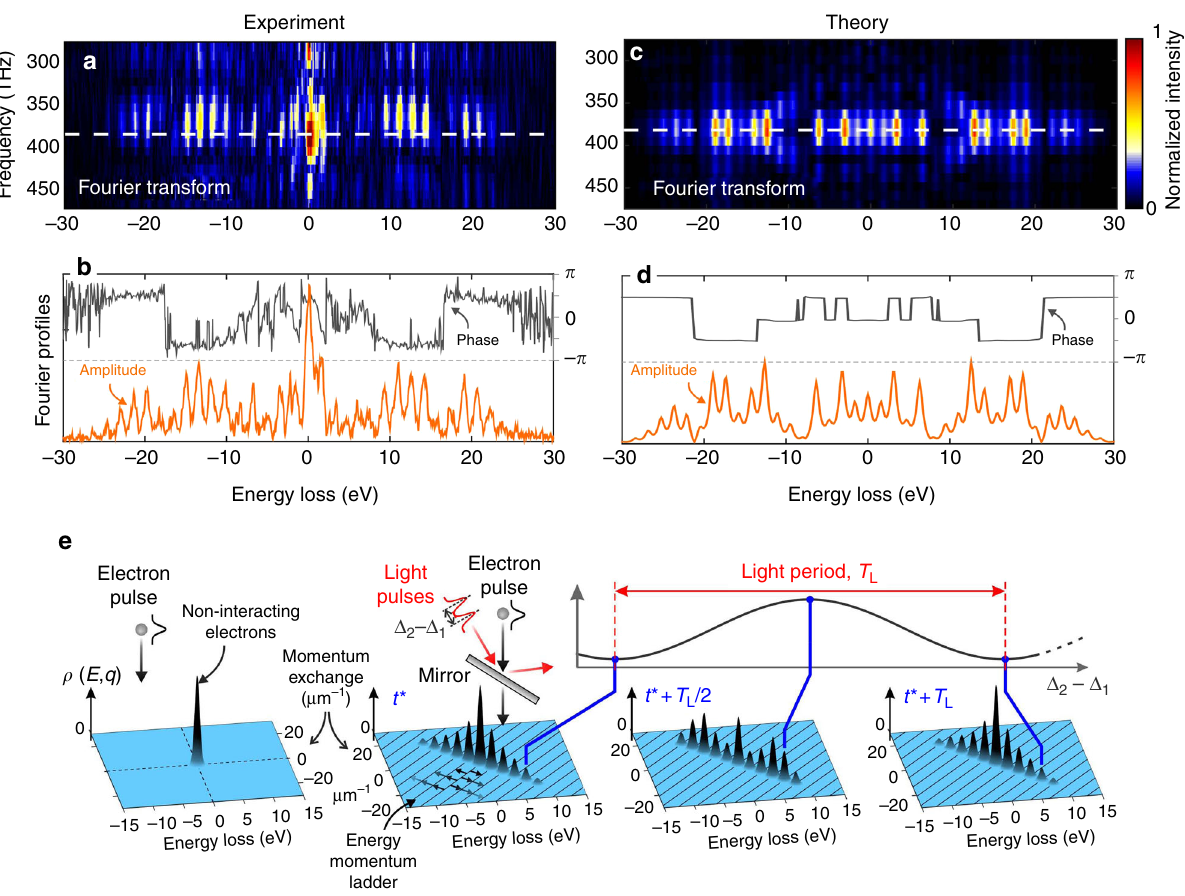
Fig. 5 Amplitude and phase modulation of the electron wave function. a Two-dimensional Fourier transform of the energy-time map plotted in Fig. 4a. b Complex spectral distribution of the electron wave function amplitude (bottom) and phase (top), extracted at the modulation frequency of 2 π /(2.6 fs) ≈ 385 THz. c , d Two-dimensional Fourier transform extracted from the calculated energy-time map plotted in Fig. 4d. e Schematic representation of electron wave function modulation, showing snapshots of the strong energy-momentum electron density redistribution for different values of the phase shift between the two optical